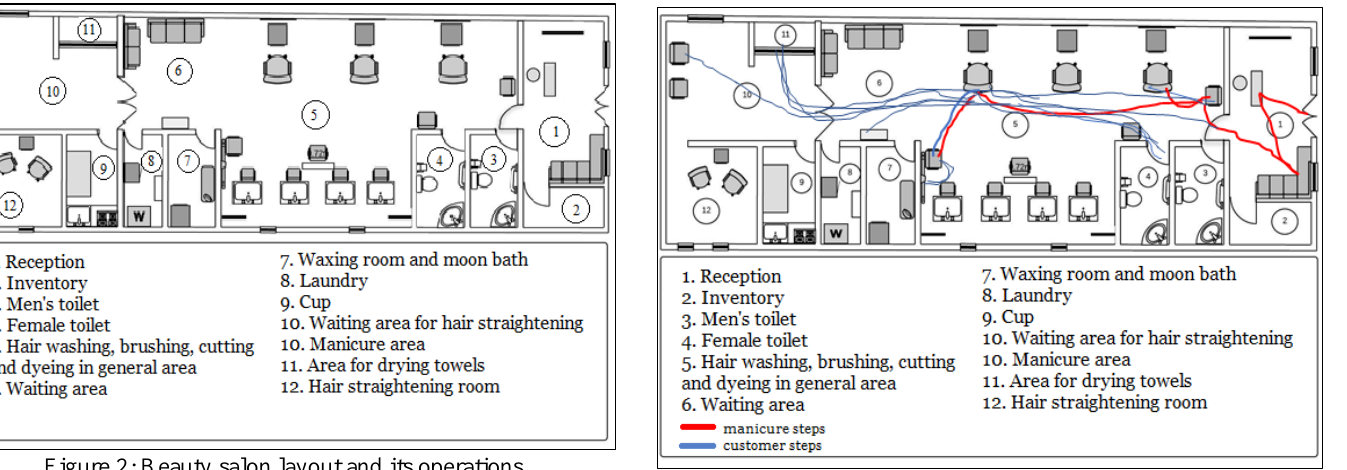
Figure 4: Flowchart map of the service